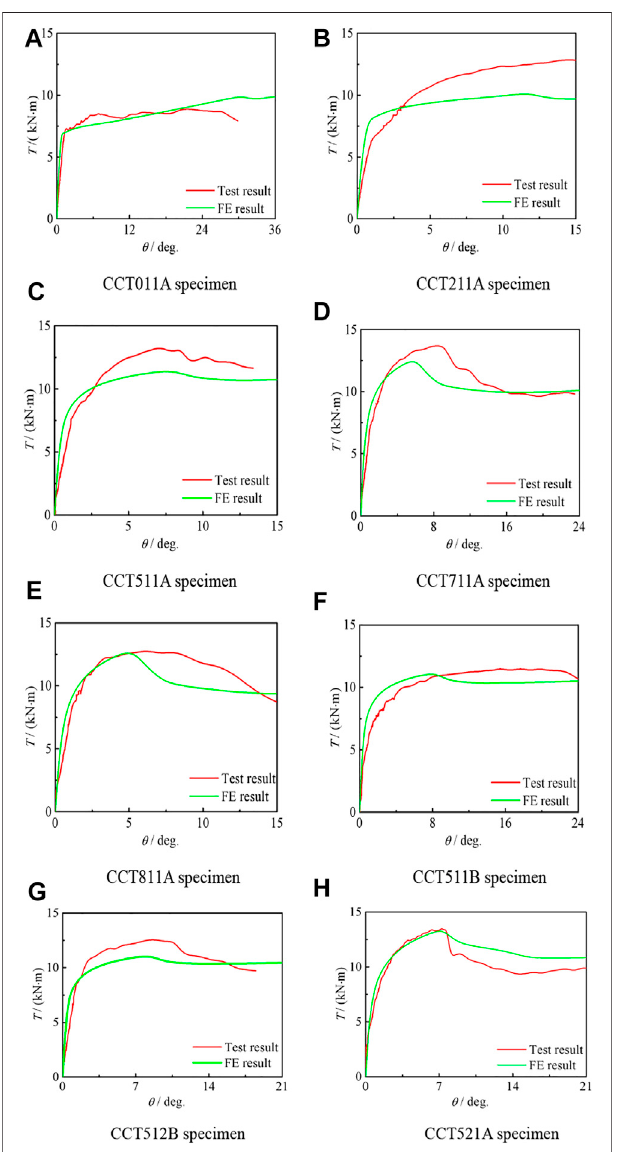
FIGURE13| Comparison between T – θ curve simulation resultsandtest results of compression torsion specimens. (A – H) Different curves between Test and FE result.